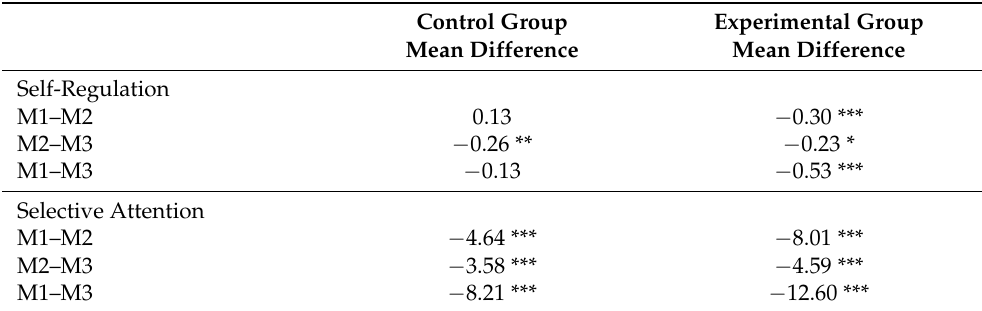
Table 4. Bonferroni’s adjusted p values for all possible pairwise differences among two dependent variables of the within-subjects factor.